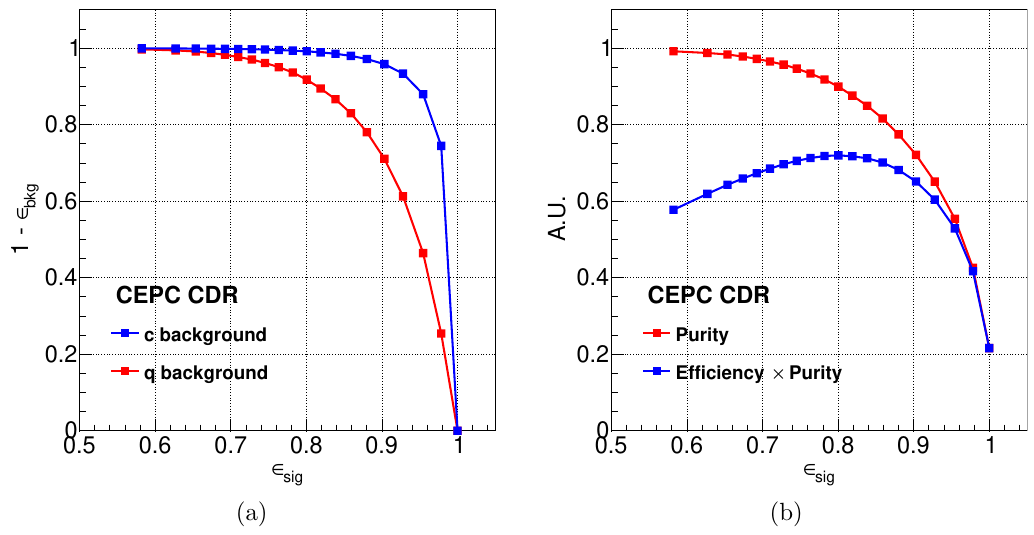
√ Figure 2 . The b -jet tagging performance of the inclusive Z → q ¯ q ( s = 91.2 GeV) sample derived from the full simulation of the CEPC baseline detector. (a) The b -jet tagging efficiency ( (cid:15) ) versus sig background-jet rejection rate ( 1 − (cid:15) ). The background-jets are classified into the light-flavor jets bkg ( u , d , and s , simply denoted by q in the legend) and the c -jet in the blue and red lines, respectively. (b) The b -jet tagging purity (red line) and efficiency × purity (blue line) versus b -jet tagging efficiency. The optimal performance is defined as the maximum efficiency × purity and is achieved with an efficiency of 80% and a purity of